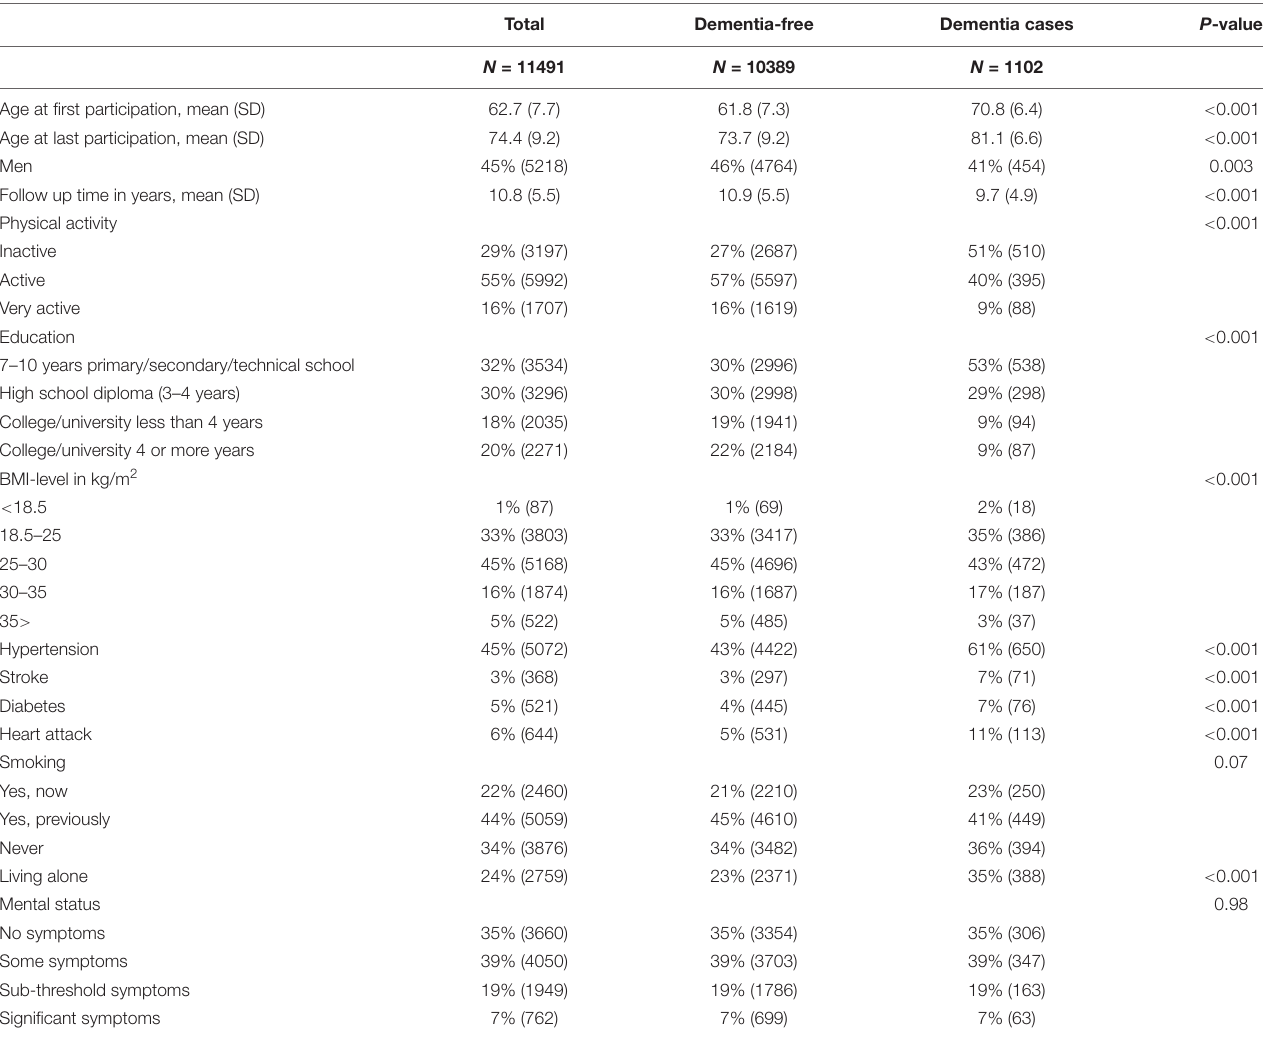
TABLE 1 | Baseline characteristics at first visit in the Tromsø Study.